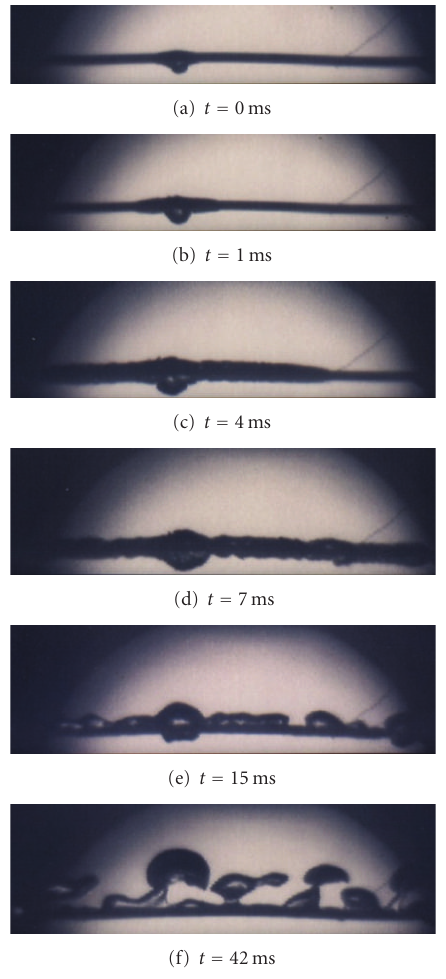
Figure 13: Vapor film behavior during direct transition to film boiling for a period of 0.02 s at atmospheric pressure in saturated FC-72 with the CS cylinder.